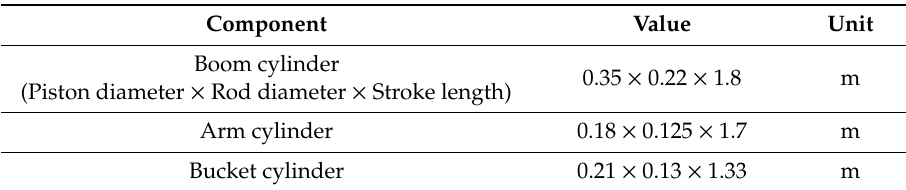
Table 1. Parameters for the excavator